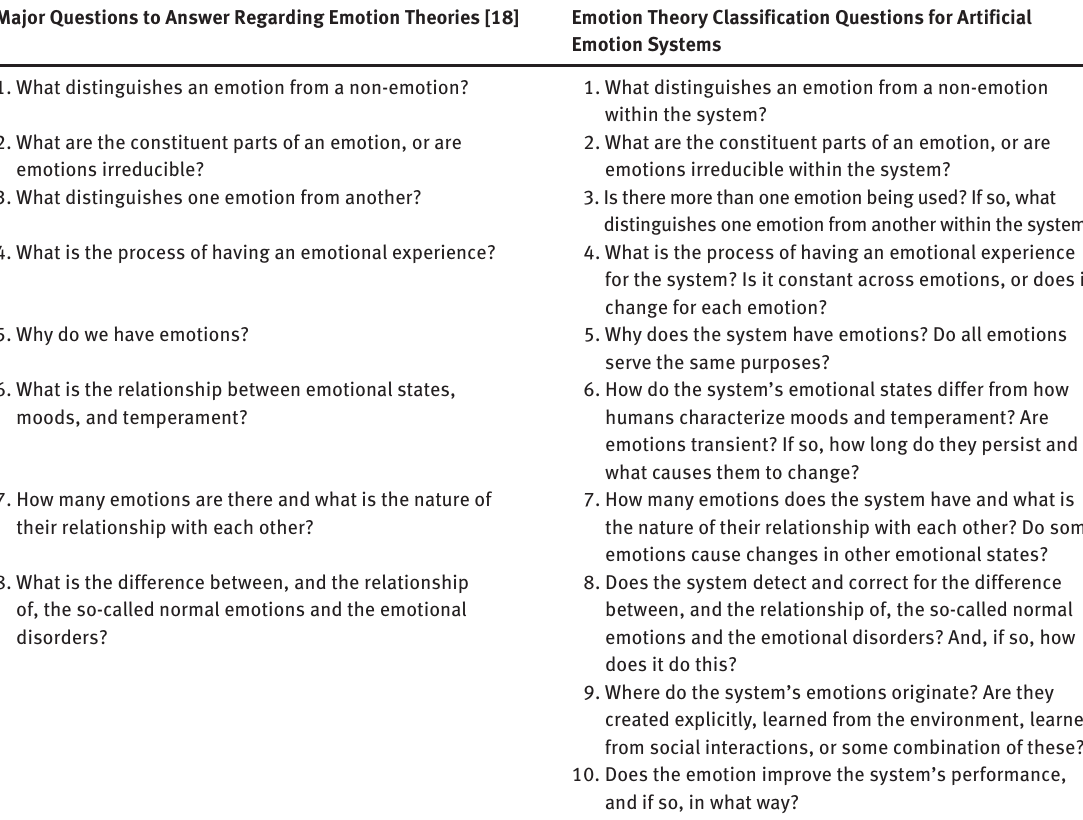
Table 1. Questions Asked by Power and Dalgleish [18] and the Emotion Theory Questions Used in this Paper for Classification. Major Questions to Answer Regarding Emotion Theories